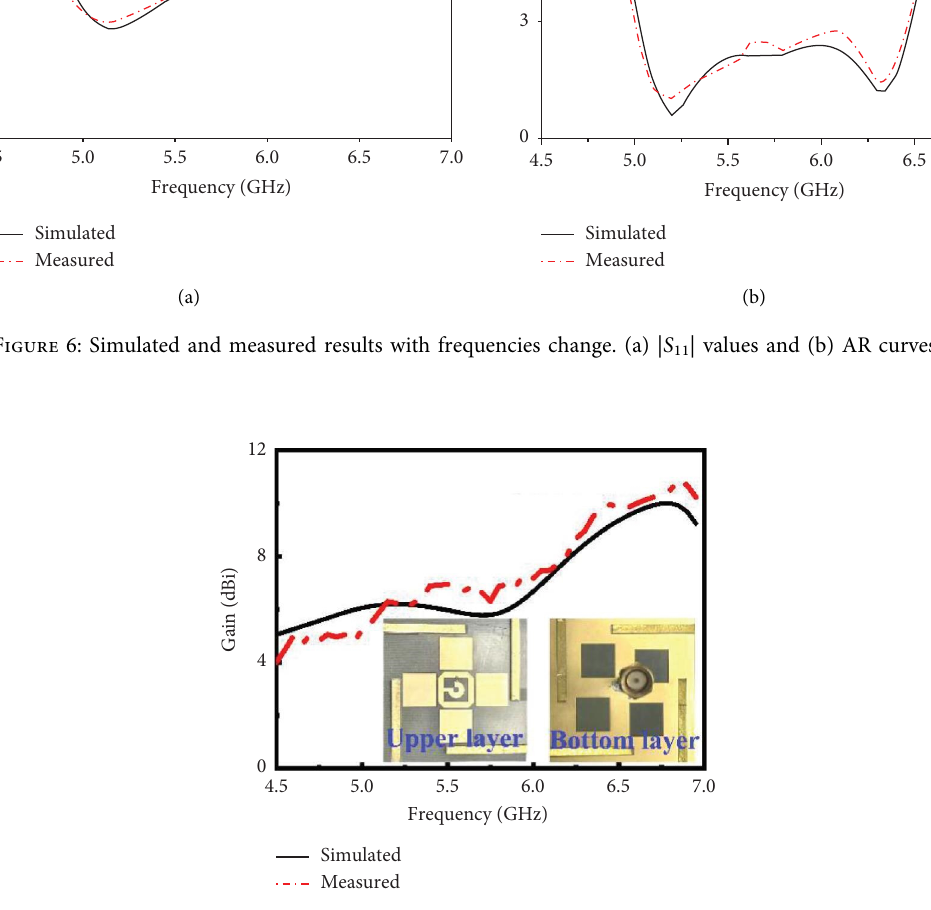
Figure 7: Simulated and measured gain values with frequencies change and the photograph of manufactured antenna.